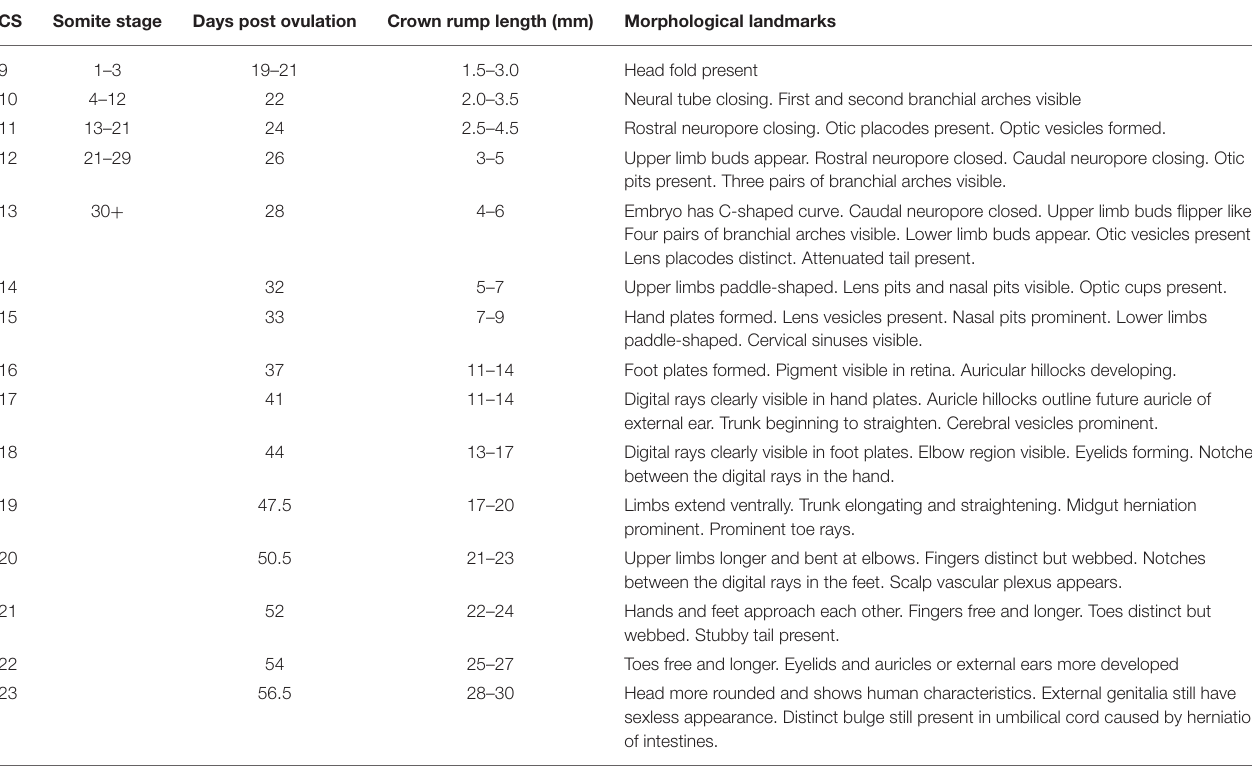
TABLE 1 | Staging criteria for human